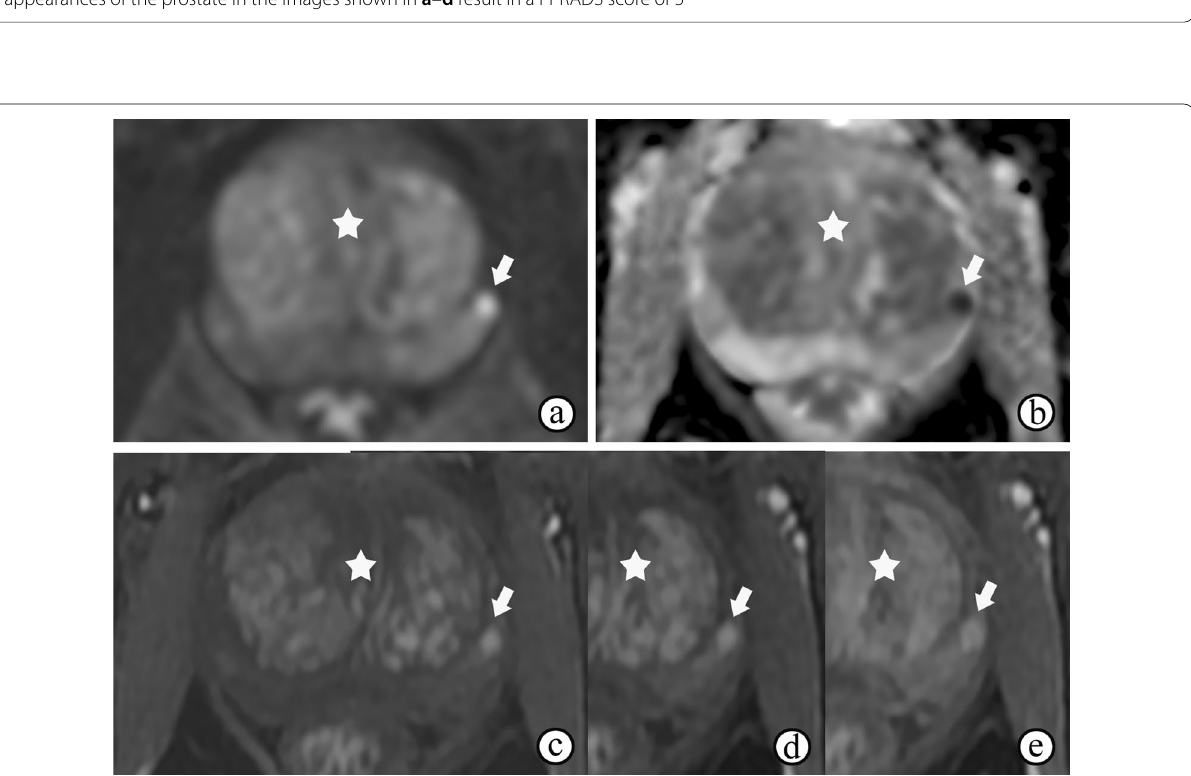
Fig. 3 Nonspecific granulomatous prostatitis in a 57-year-old male with dysuria and urinary retention for 1 month and a serum PSA level of 13.22 ng/mL. a , b DWI at a b-value of 1400 s/mm 2 and ADC maps show a focal nodule with obviously restricted diffusion (arrow) in the left peripheral zone of the prostate. c–e DCE imaging shows early and prolonged enhancement of the nodule (arrow). The appearances of the nodule in a–e result in a PI-RADS score of 4. Note the prostatic hyperplasia in the TZ ( ☆ ), which may have caused the symptoms of dysuria and urinary